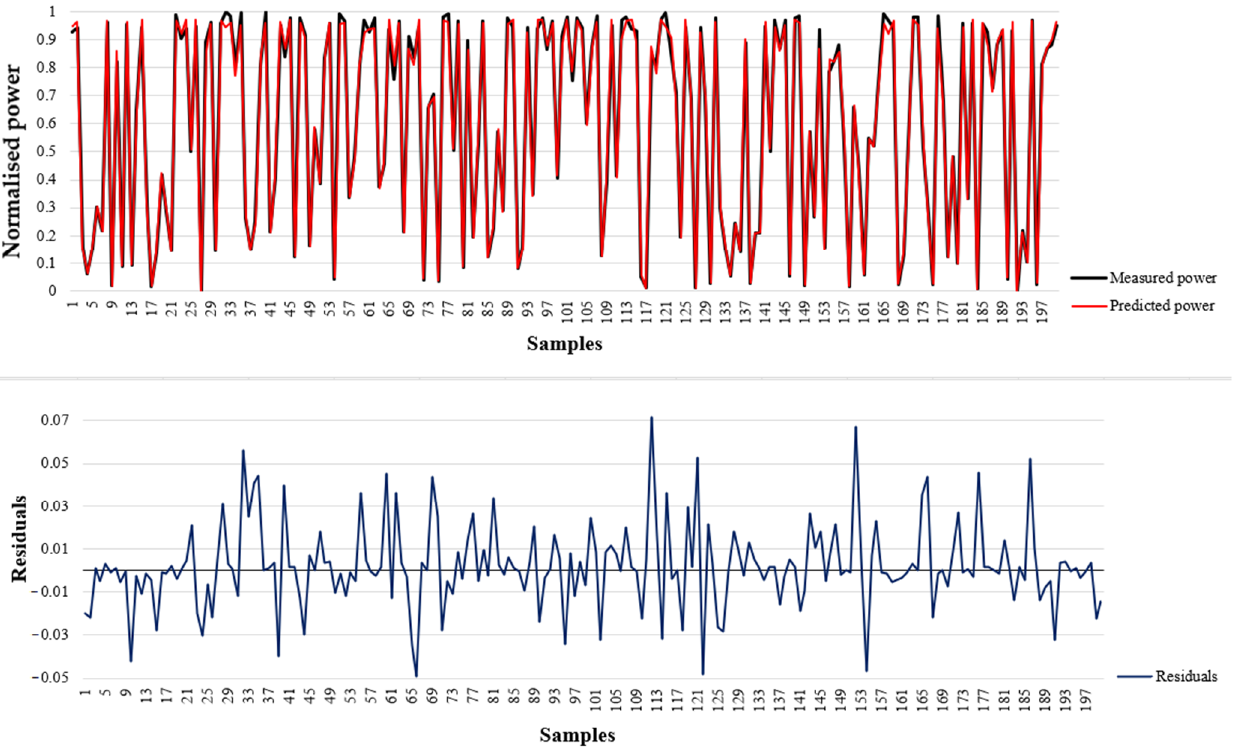
Figure 9. Sample of the normalised measured power and predicted power by ANN model II and their residuals.